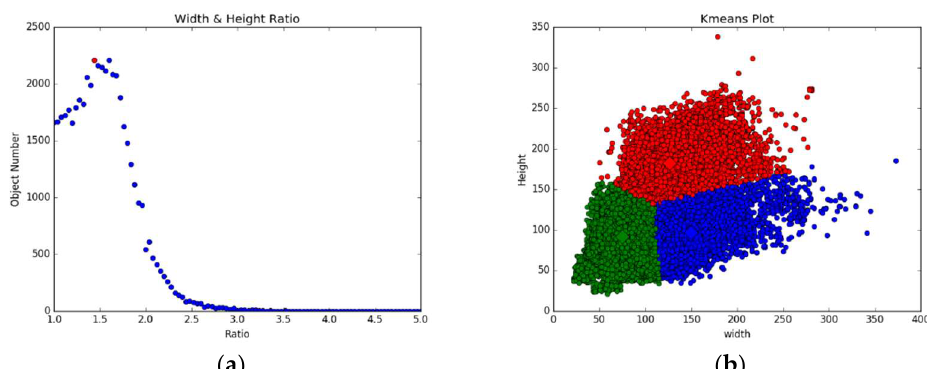
Figure 8. Box statistics of training samples: ( a ) The distribution of boxes’ aspect ratios; ( b ) Clustering results of aspect ratio of boxes; the size of boxes are between 30 and 300